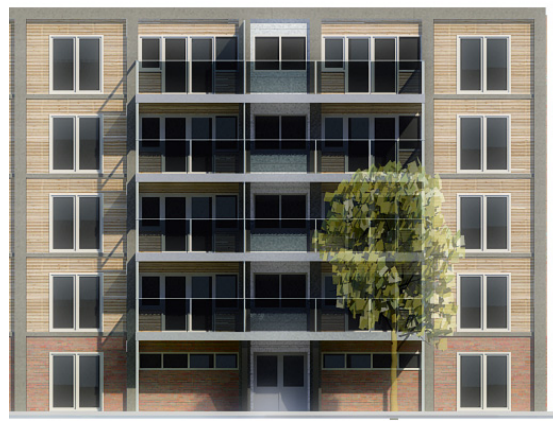
Figure 15. Front façade (west) of the refurbishment design.